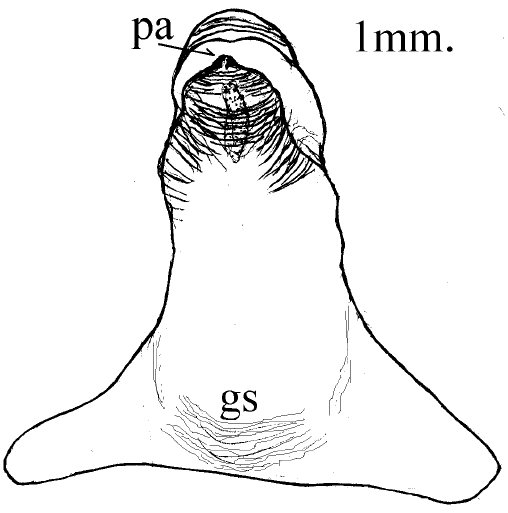
F IG .7- Male imago's genitalia, ventral view